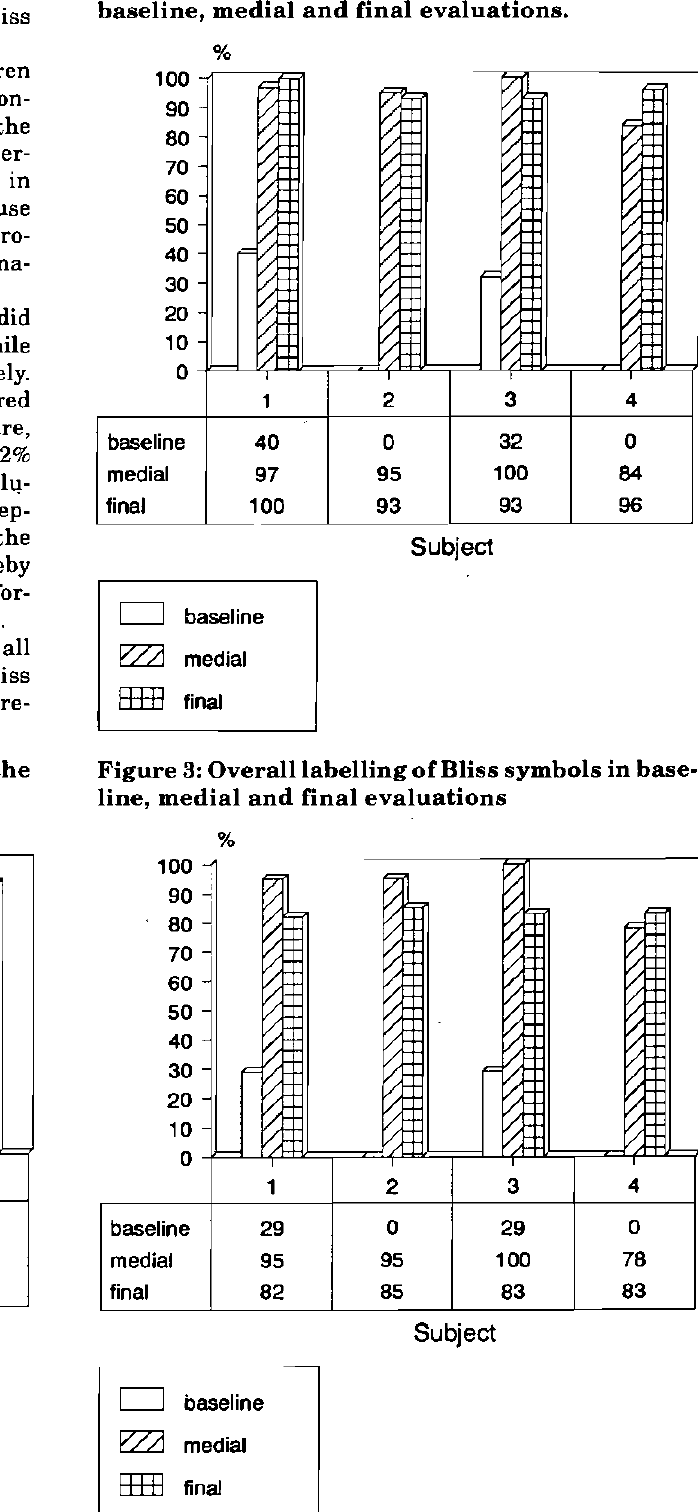
Figure 2. Overall recognition of Bliss symbols in baseline, medial and final evaluations.